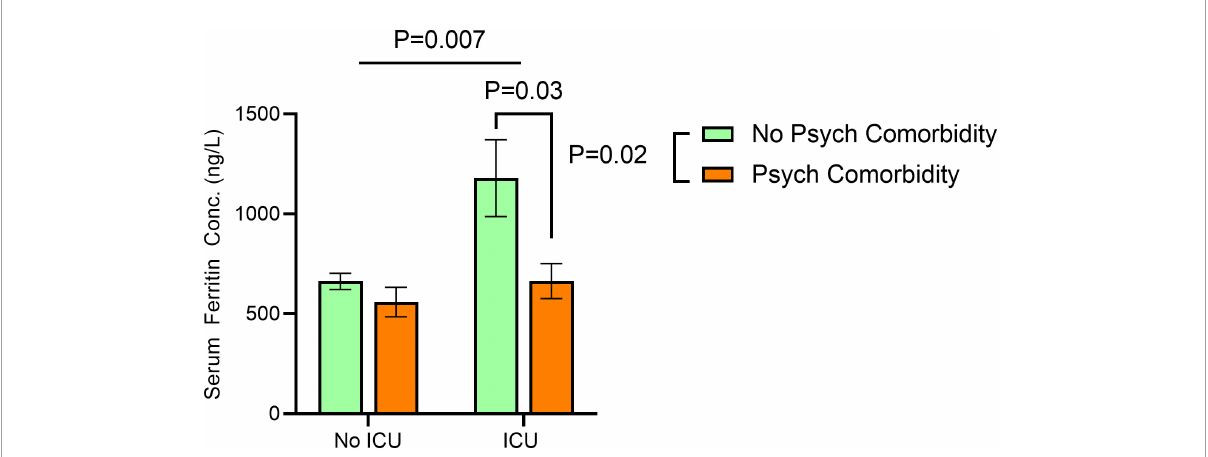
FIGURE1 Effects of ICU admission and comorbid psychiatric conditions on serum ferritin concentrations. Significant effects for ICU admission [ F (1, 601) = 7.344. P = 0.007], and the presence of comorbid psychiatric conditions [ F (1, 601) = 5.205, P = 0.02] on serum ferritin concentration correcting for age at time of SARS-CoV-2 positive test by two-way ANOVA. Error bars represent 95% confidence interval.